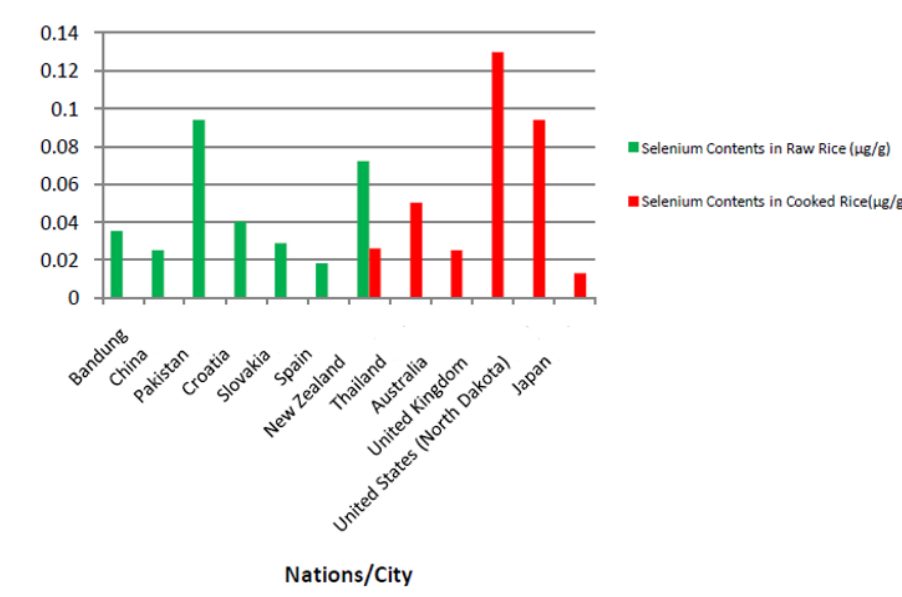
Figure 2. Comparison chart levels of selenium in raw rice or cooked rice in some countries Source: reference no 6 Table 1. Selenium concentration in the soil and rice by location in Indonesia Area Selenium Soil Rice Papua 1.31±0.07 0.068±0.0015